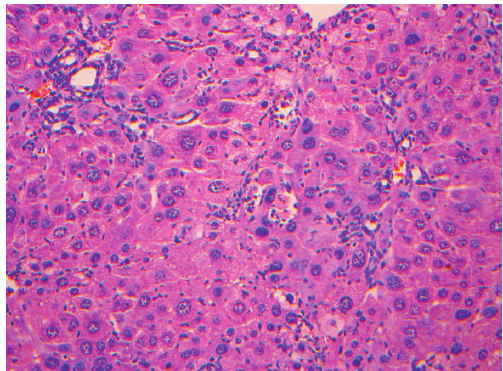
Figure 2: The pathological stage of the 2nd–4th week is S1. The figure describes the general appearance of liver pathology: the liver was slightly swollen, the color was slightly gloomy, and the texture was normal. Under the microscope, the hepatic lobular architecture was integrated, the structure of chloasma hepaticum was not clear, the hepatocytes showed vacuolar degeneration, the structure of the portal area was still clear, and no fibrous hyperplasia was observed. HE. Bar 5200 mm.